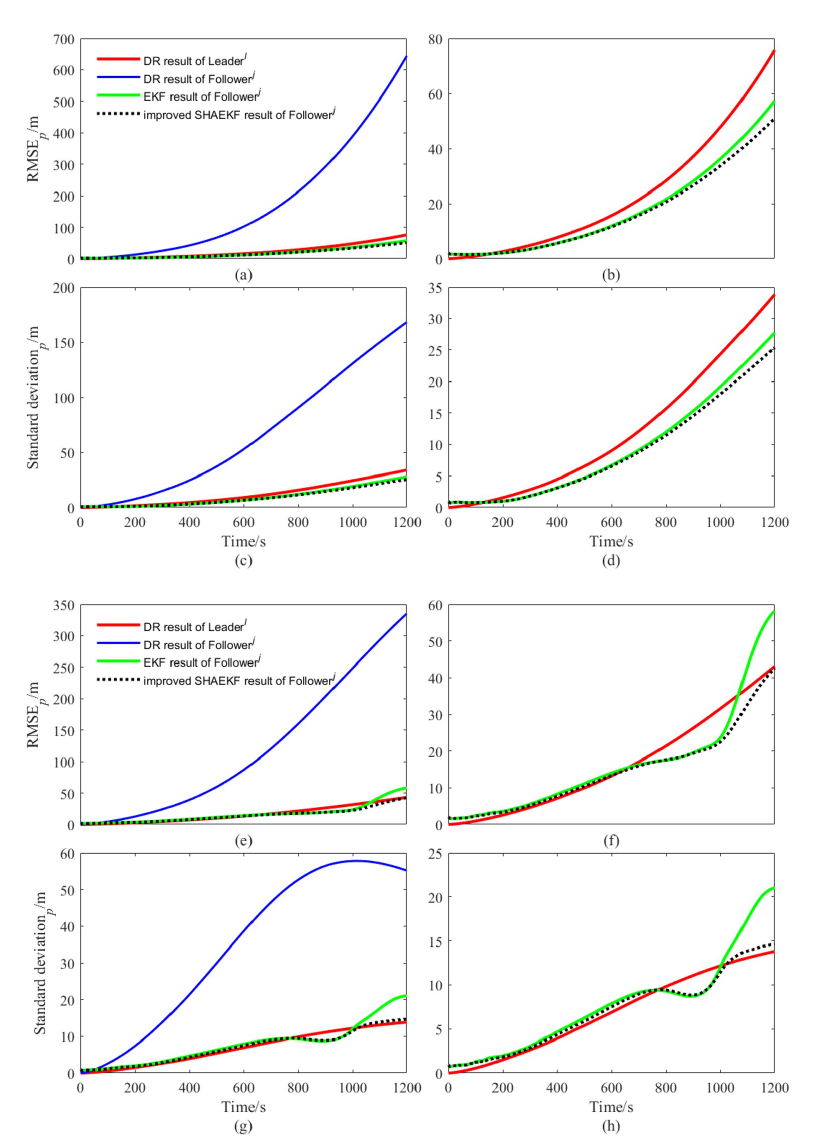
Figure 7. Comparison diagram of localization errors under a steady-state system. ( a – d ) Description of the results of AUVs that moved along a straight line at a uniform constant speed; ( e – h ) description of the results of AUVs that moved along a curve at a uniform constant speed; ( a , b , e , f ) description of the change in the root mean square of localization errors with time for each algorithm; ( c , d , g , h ) description of the variation of the standard deviation of localization errors with time for each